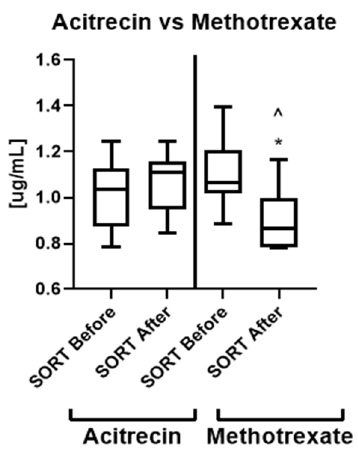
Figure 6. Concentrations of SORT in patients before and after the treatment with acitretin and methotrex- ate. * means statistically significant difference in SORT concentration on acitretin vs. methotrexate after treatment; ˆ means statistically significant difference in SORT concentration before and after treatment in methotrexate